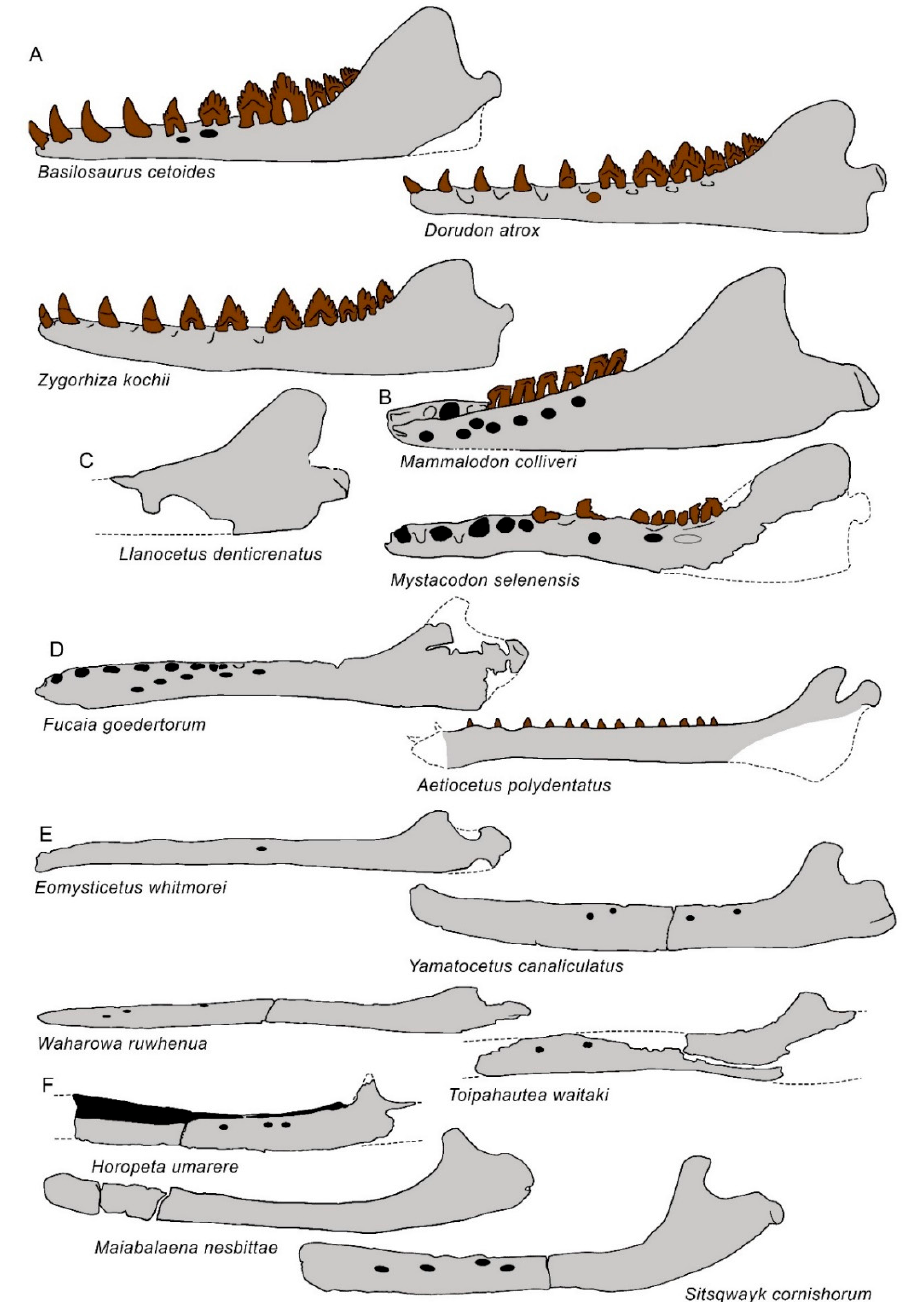
Figure 16. Schematic representations of the dentary of advanced archaeocetes and nonbalaenomorph mysticetes in lateral view. ( A ) Archaeocetes. ( B ) Mammalodontidae. ( C ) Other early diverging mysticetes. ( D ) Aetiocetidae. ( E ) Eomysticetidae. ( F ) Stem-Balaenomorpha and Maiabalaena nesbittae . Not to scale. Dentaries are represented as if they shared the same anteroposterior length.